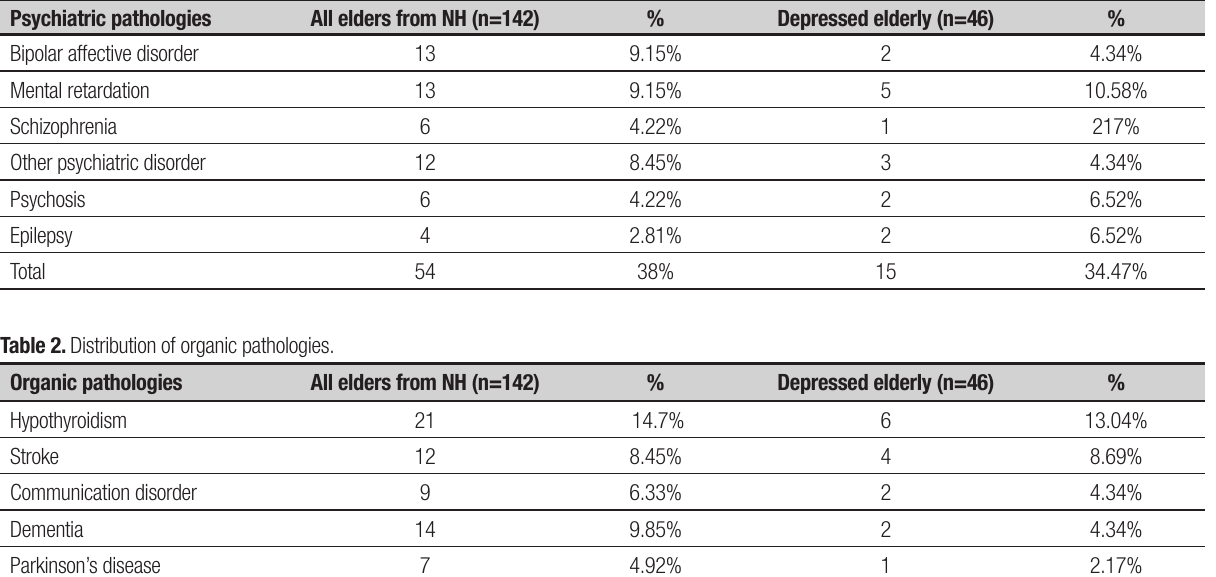
Table 1. Distribution of psychiatric pathologies.